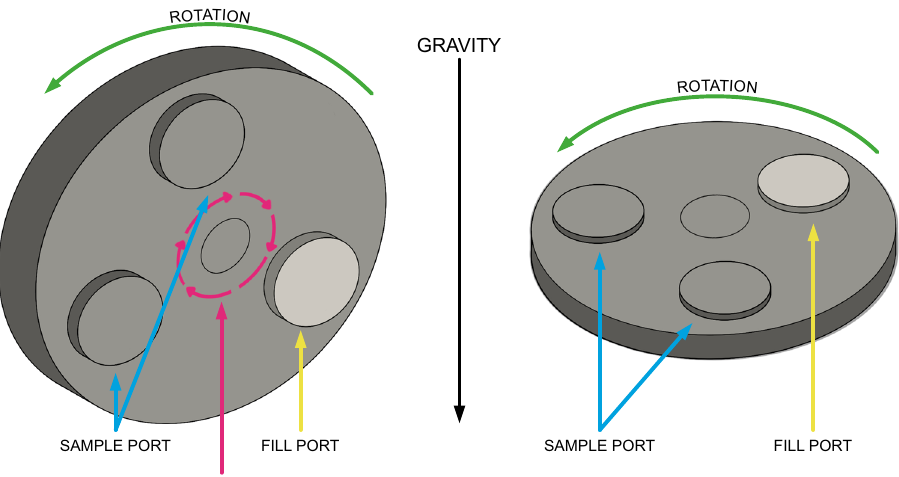
Fig. 2 3D orientation of a rotating wall vessel (RWV) with the direction of the gravity vector included. Left: Simulated microgravity showing a typical microbe path with gravity vectors canceling in the completely vertical orientation. Right: Normal gravity control with a horizontal